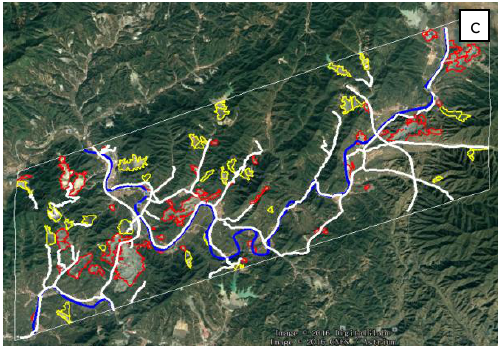
Fig. 3 Extracting map of stopes and tailings ponds based on Ultra-low-grade Iron Index (ULII) in the study area. a) ULII image; b) Stopes and tailings ponds (in white color) extracted with the threshold 0.84; c) High-resolution GeoEye image (Tailings pond is yellow, and stope is red).